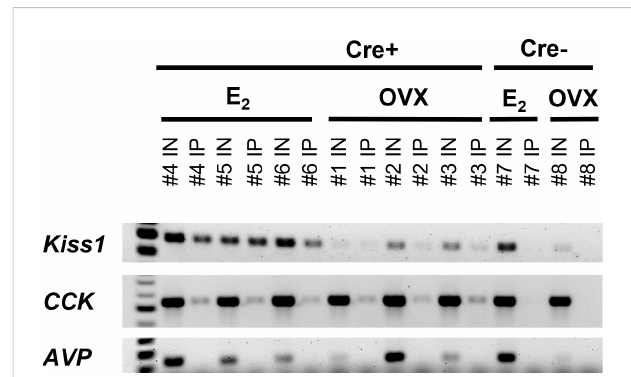
FIGURE 2 RT-PCR validation of successful isolation of ribosomal mRNA from MeA Kiss1 cells in female mice. The number above each lane denotes the pooled sample number. Input samples contain all cells in the MeA, including, but not limited to Kiss1 cells. IP samples contain mRNA transcripts isolated from the ribosomes of only MeA Kiss1 cells, but not other non- Kiss1 MeA cells. Kiss1 and Cck are identi fi ed in both the Input and IP samples as expected, whereas Avp transcripts were located in the Input, but not the IP samples, indicating that Avp is not expressed in MeA Kiss1 cells. For our Cre- control mice, the Input samples express bands for Kiss1, Cck, and Avp , whereas the IP samples, as expected due to the lack of the HA+ tagonthe ribosomes, donot contain mRNAfor these